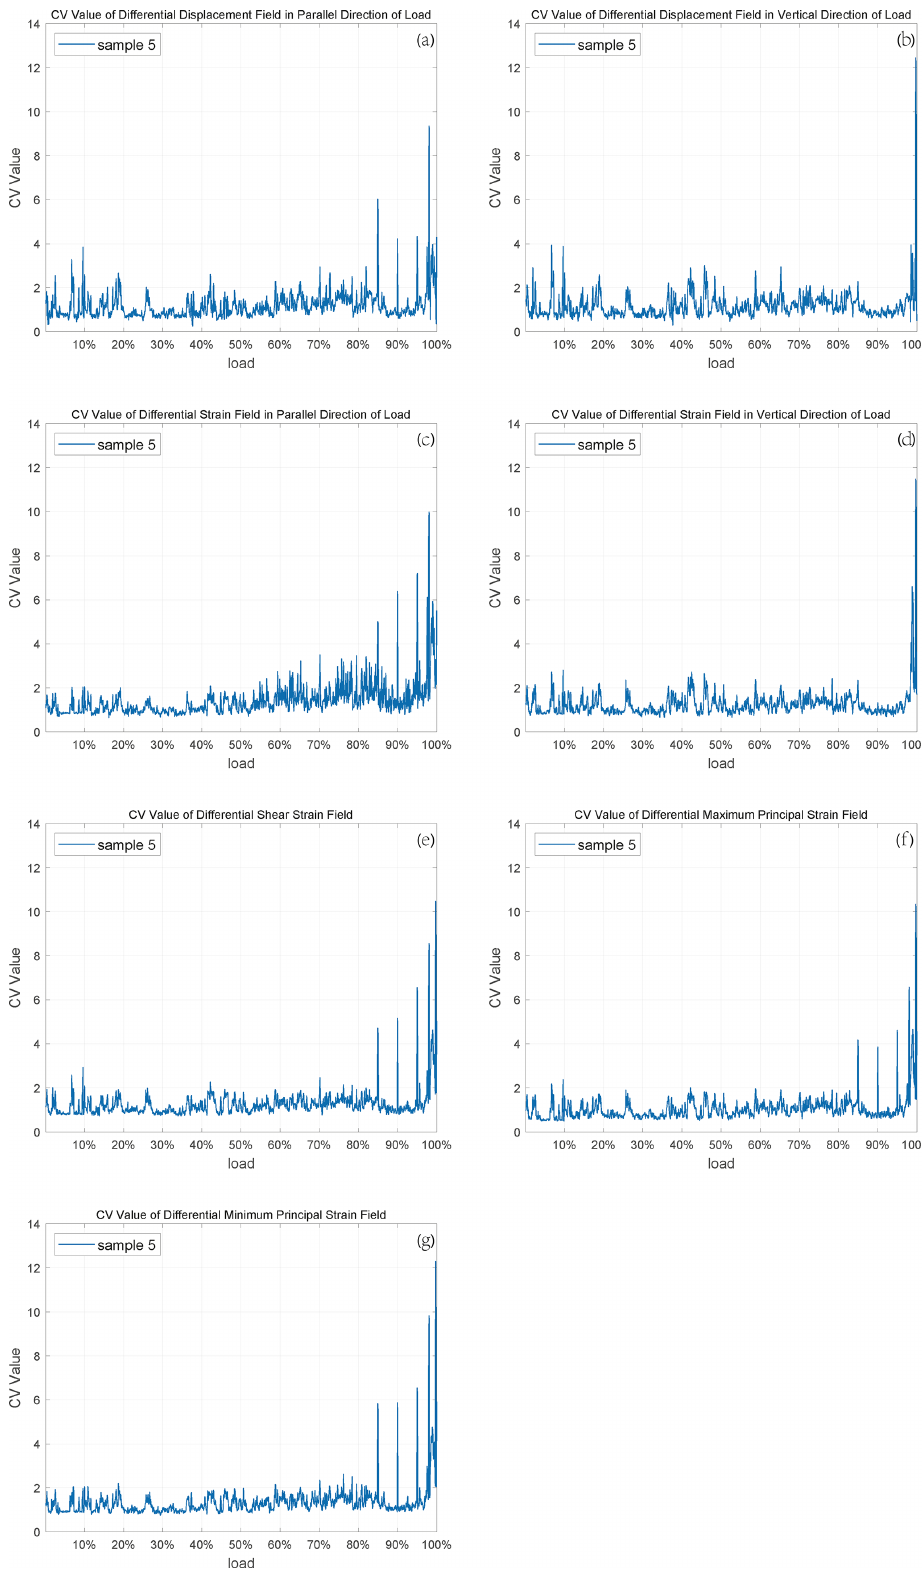
Figure A4. CV images of sample